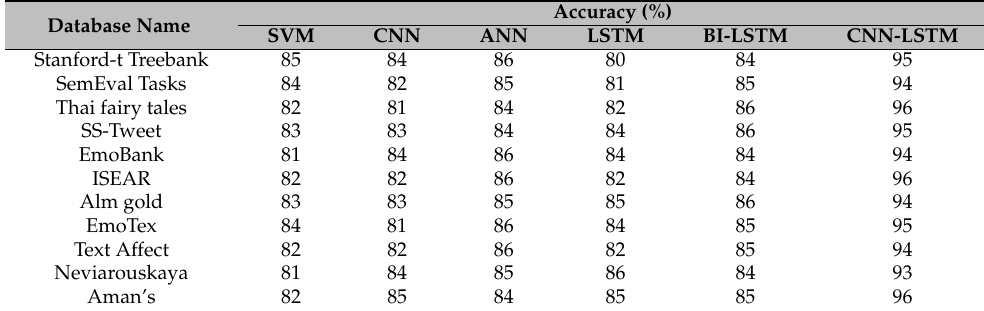
Table 4. Performance analysis for BOW + IF-IDF with CNN-LSTM based on accuracy.